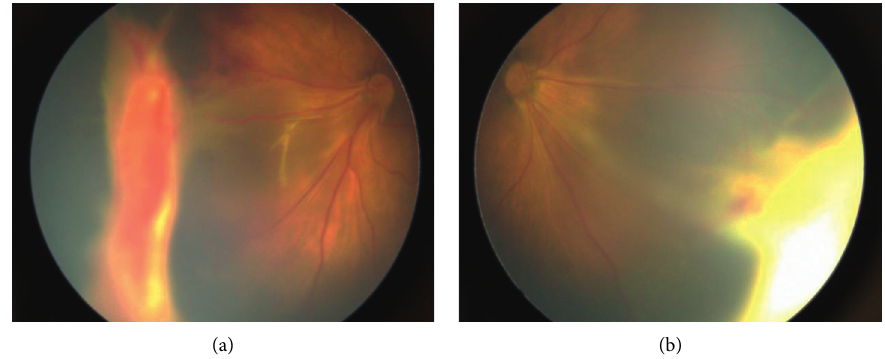
Figure 3: Colour fundus of case 2. (a) Right eye. (b) Left eye. Both eyes were stage 4a accompanied by macular